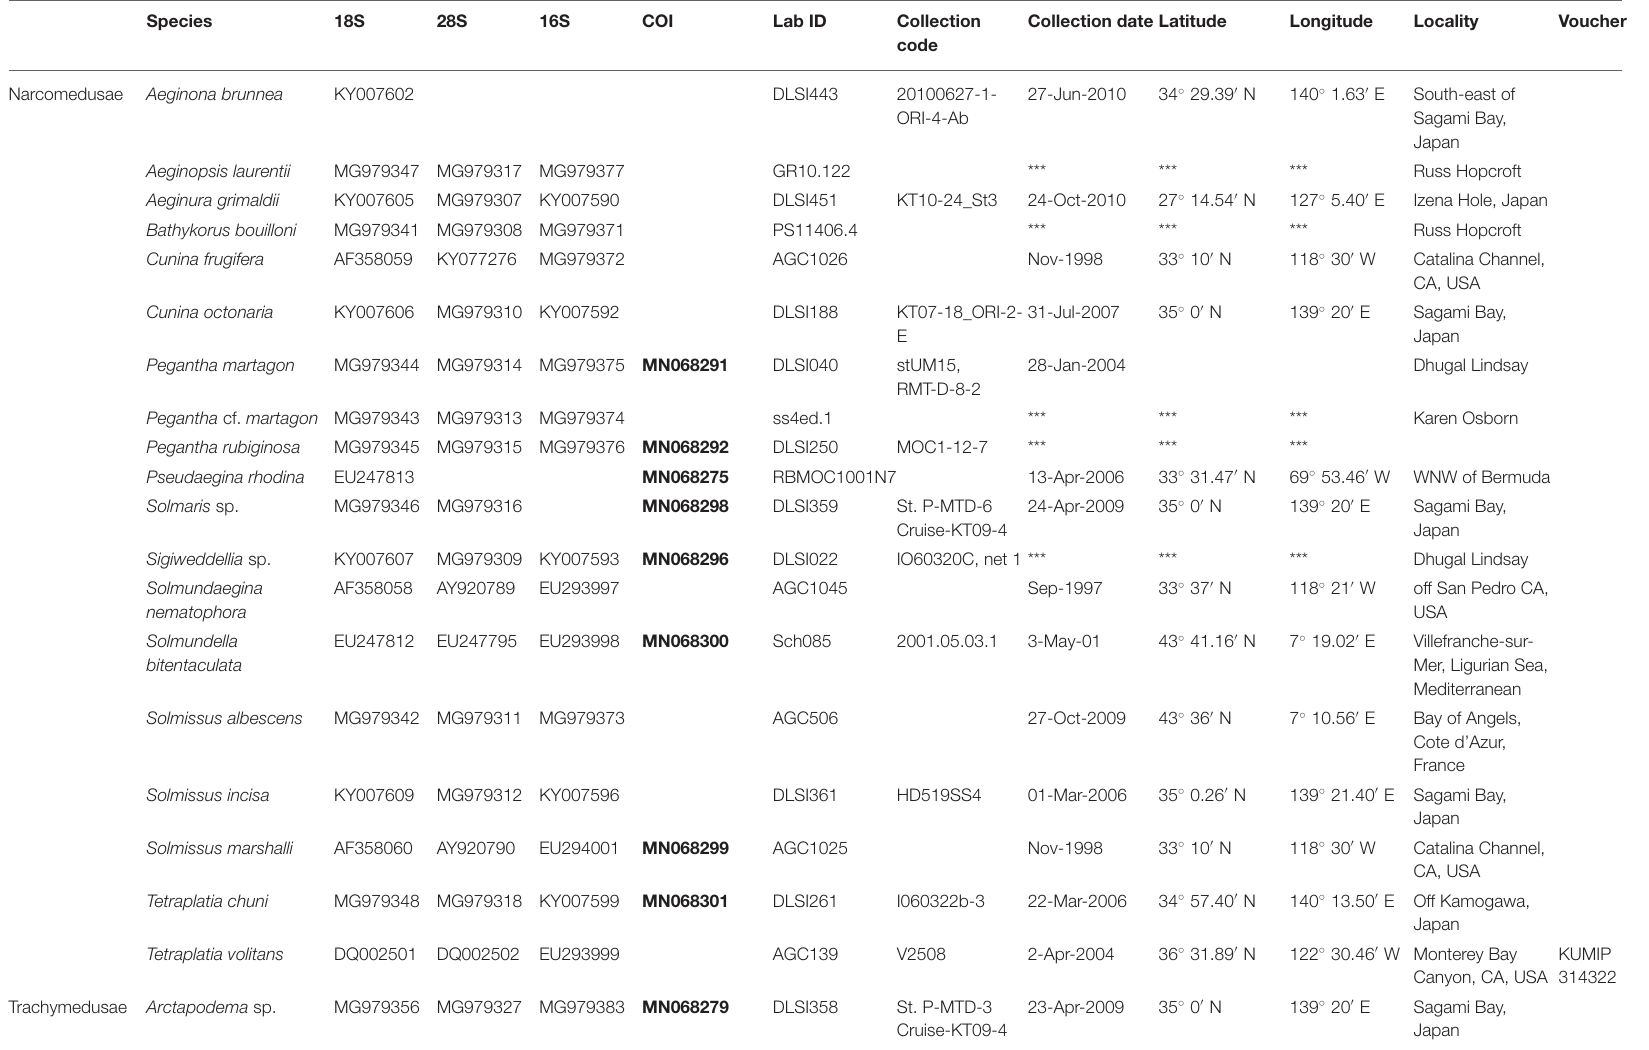
TABLE 1 | Genbank accession numbers for sequence data used in phylogenetic